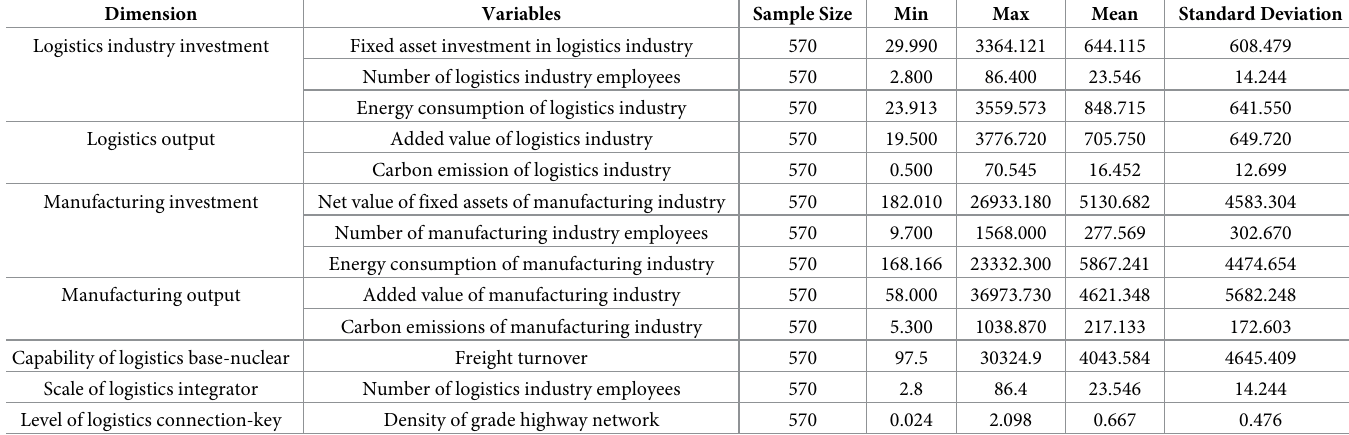
Table 3. Descriptive statistics of core